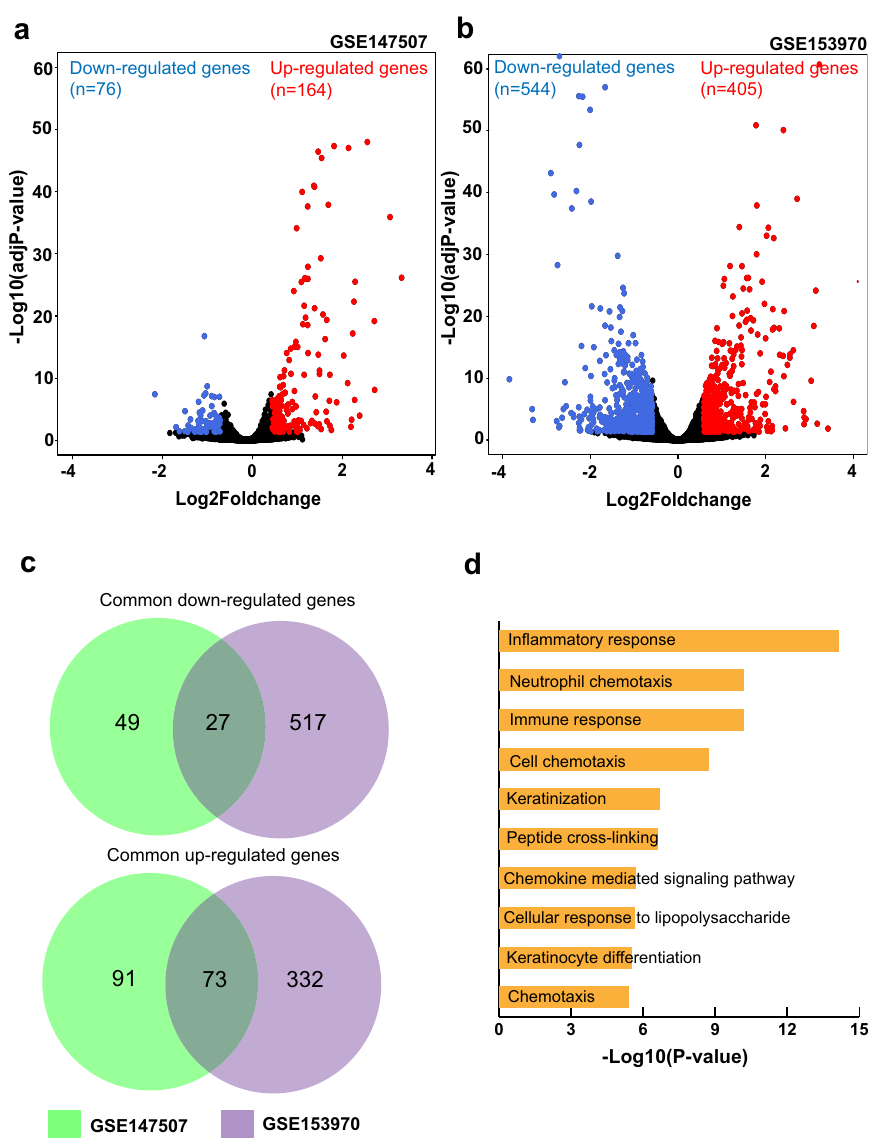
Figure 1. High throughput gene expression analysis of SARS-CoV-2 infection in human lung epithelial cells. (a,b) Volcano plots showing the proportion of differentially expressed genes on SARS-CoV-2 infection in human lung epithelial cells [from GSE147507 and GSE153970, respectively]. (c) Venn diagram depicting genes commonly up-/down-regulated as per both studies. (d) Top 10 biological processes associated with common differentially expressed genes on SARS-CoV-2 infection of human lung epithelial